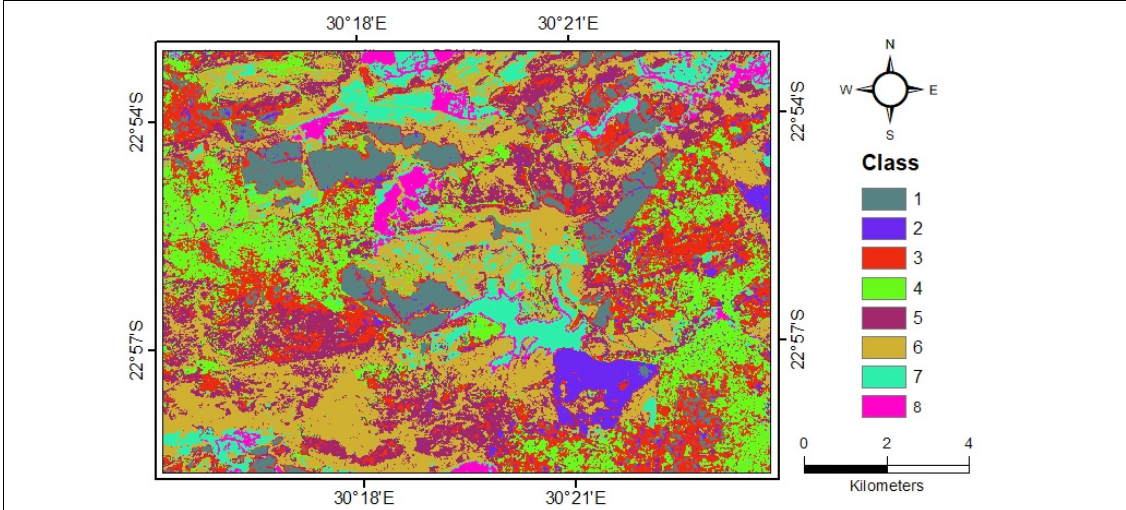
Figure 4: The difference image.